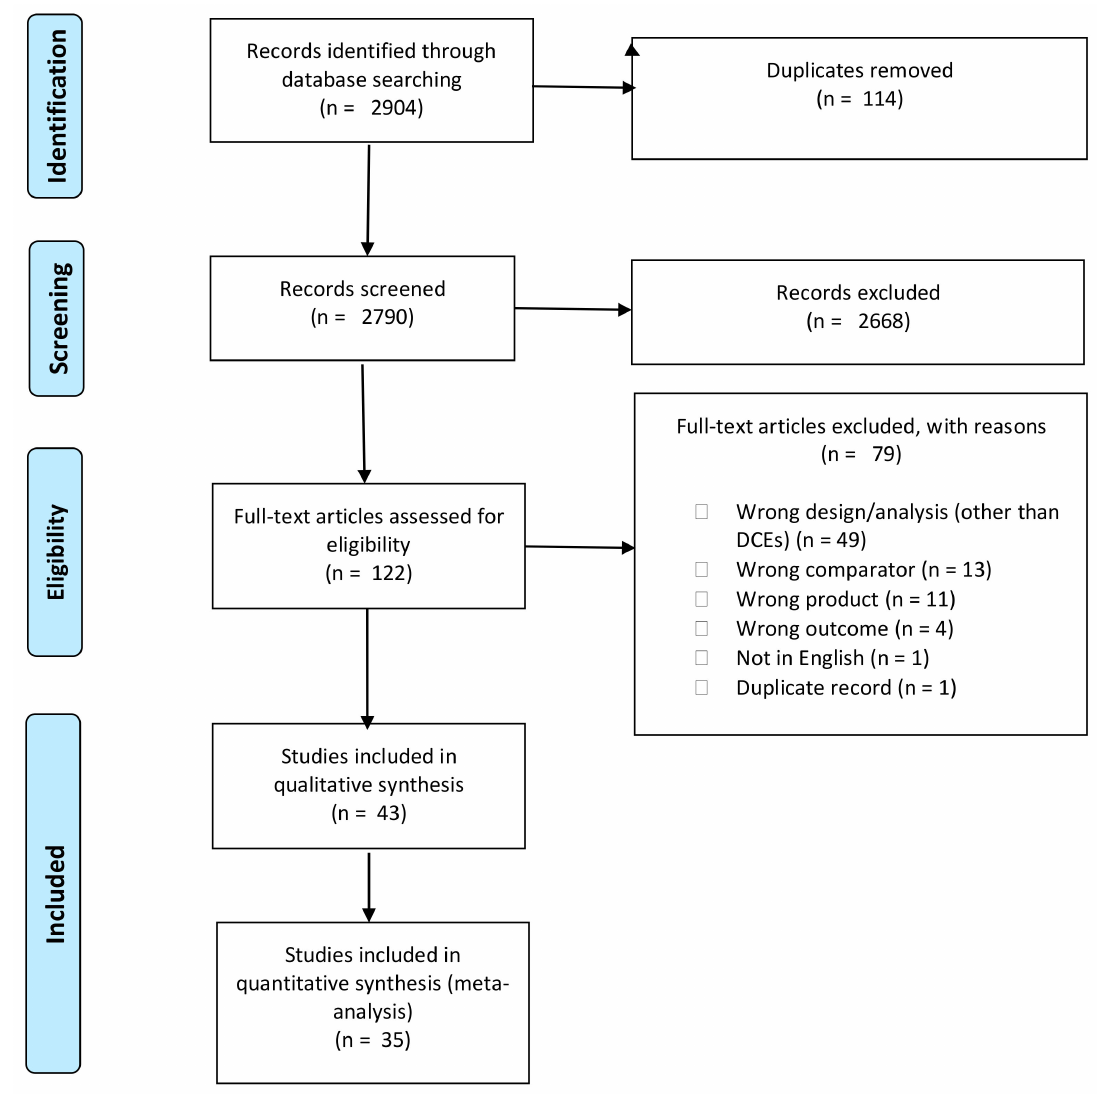
Figure 1. PRISMA flow